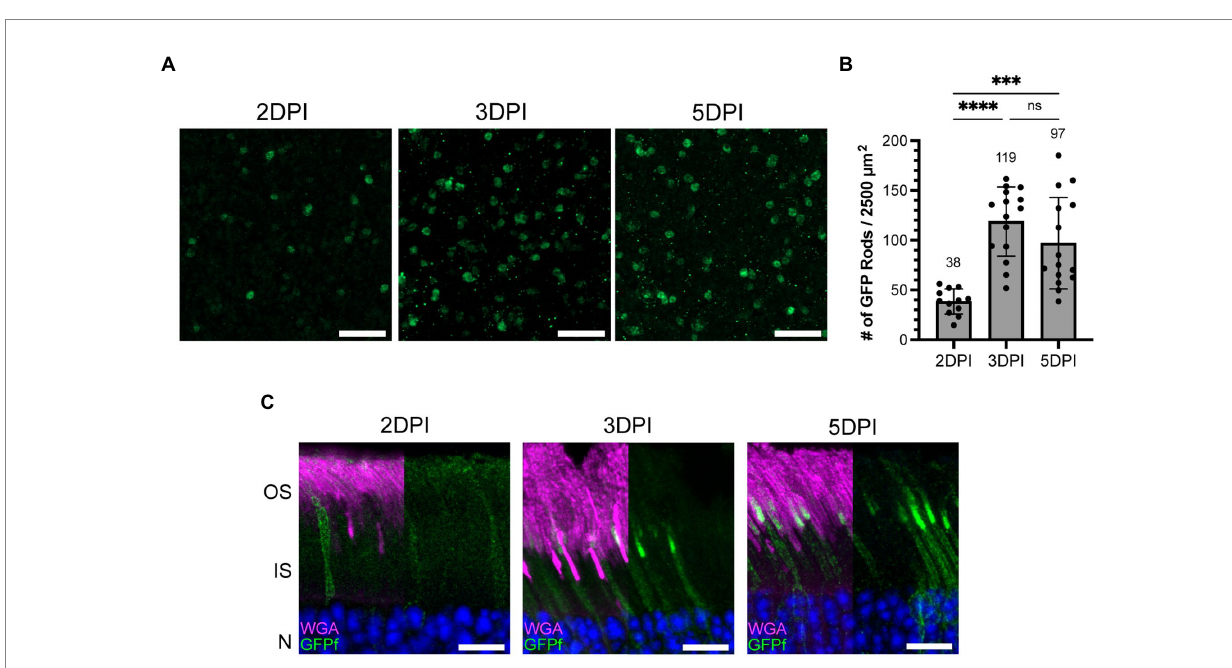
FIGURE 3 The number of rod photoreceptors expressing GFPf in the Nrl:CreERT2 mouse stabilizes 3 days post tamoxifen induction. (A) Representative retinal whole mounts from Nrl:CreERT2/GFPf stained with anti-GFP antibody showing GFP expression in the rod synapse at 2, 3, and 5 days post-injection (DPI). Scale Bars, 10 μ m. (B) Bar graph plotting the number of GFP positive rods in a 2,500 μ m 2 retinal area. Mean for each timepoint is displayed above the bar. Error bars represent S.D. A one-way ANOVA was preformed: **** p < 0.0001, *** p = 0.0003, ns p = 0.2172. (C) Representative retinal cross-sections from Nrl:CreERT2/GFPf mice at 2, 3, and 5 DPI stained with anti-GFP antibody and WGA. Nuclei are counterstained with Hoechst. Scale Bars, 10 μ